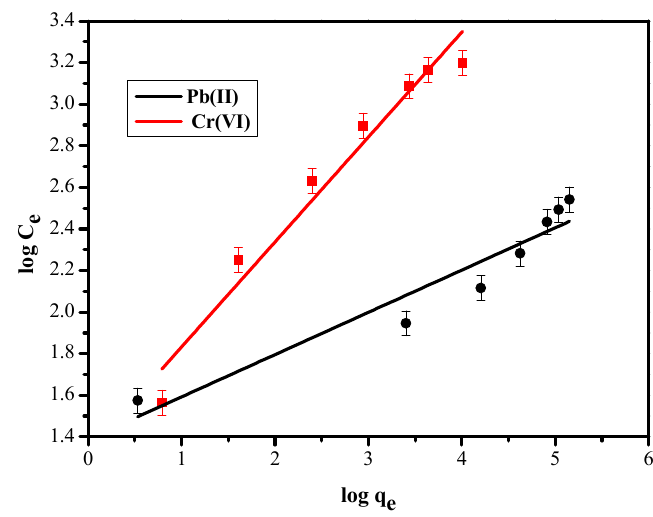
Figure 6. Linear fit of experimental data obtained using Freundlich isotherm model (adsorbent mass: 0.80 g/100 mL for Pb(II) at pH 4.6 and 1.00 g/100 mL for Cr(VI) at pH 4.0; temperature: 25 °C).